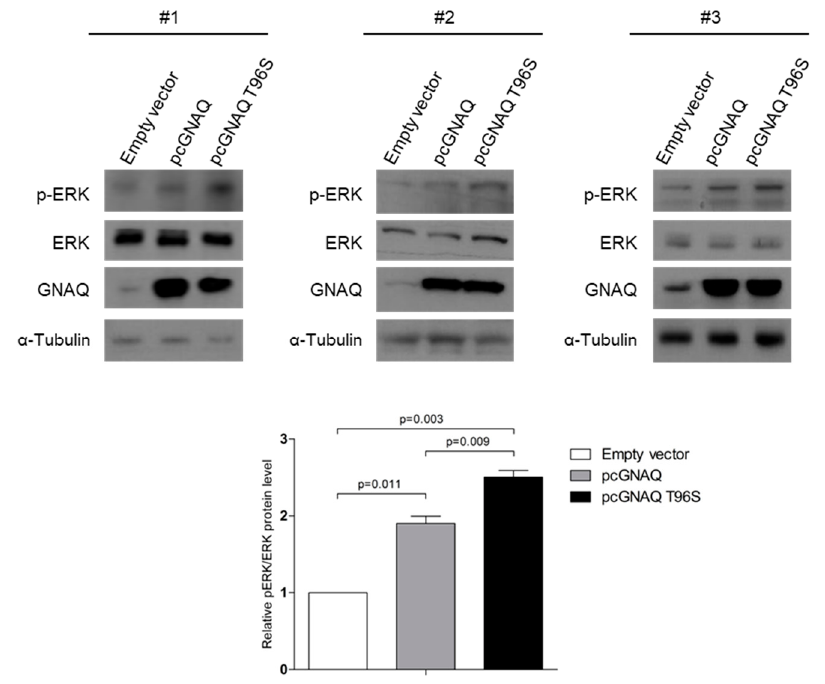
Figure 3. Increased ERK signaling due to GNAQ T96S mutation. SK-Hep-1 cells were transfected with the control vector, pcGNAQ, or pcGNAQ T96S. Western blot was carried out using three independently transfected cell sets to detect total and phosphorylated forms of ERK. Anti-ERK (1:500), anti-pERK (1:500), and anti-GNAQ (1:500) antibodies were used. Comparable loading amounts were confirmed by detection with anti- α -tubulin (1:2000) antibody. Phosphorylated ERK levels were normalized by the total ERK levels in the plot shown at the lower panel.